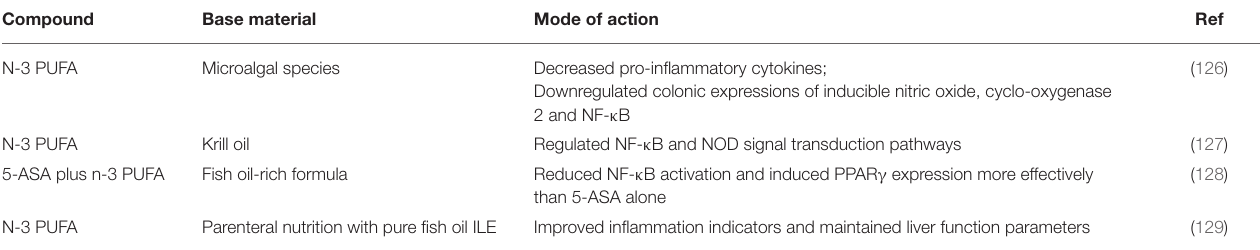
TABLE 3 | Effect of n-3 PUFAs on inflammatory bowel disease.